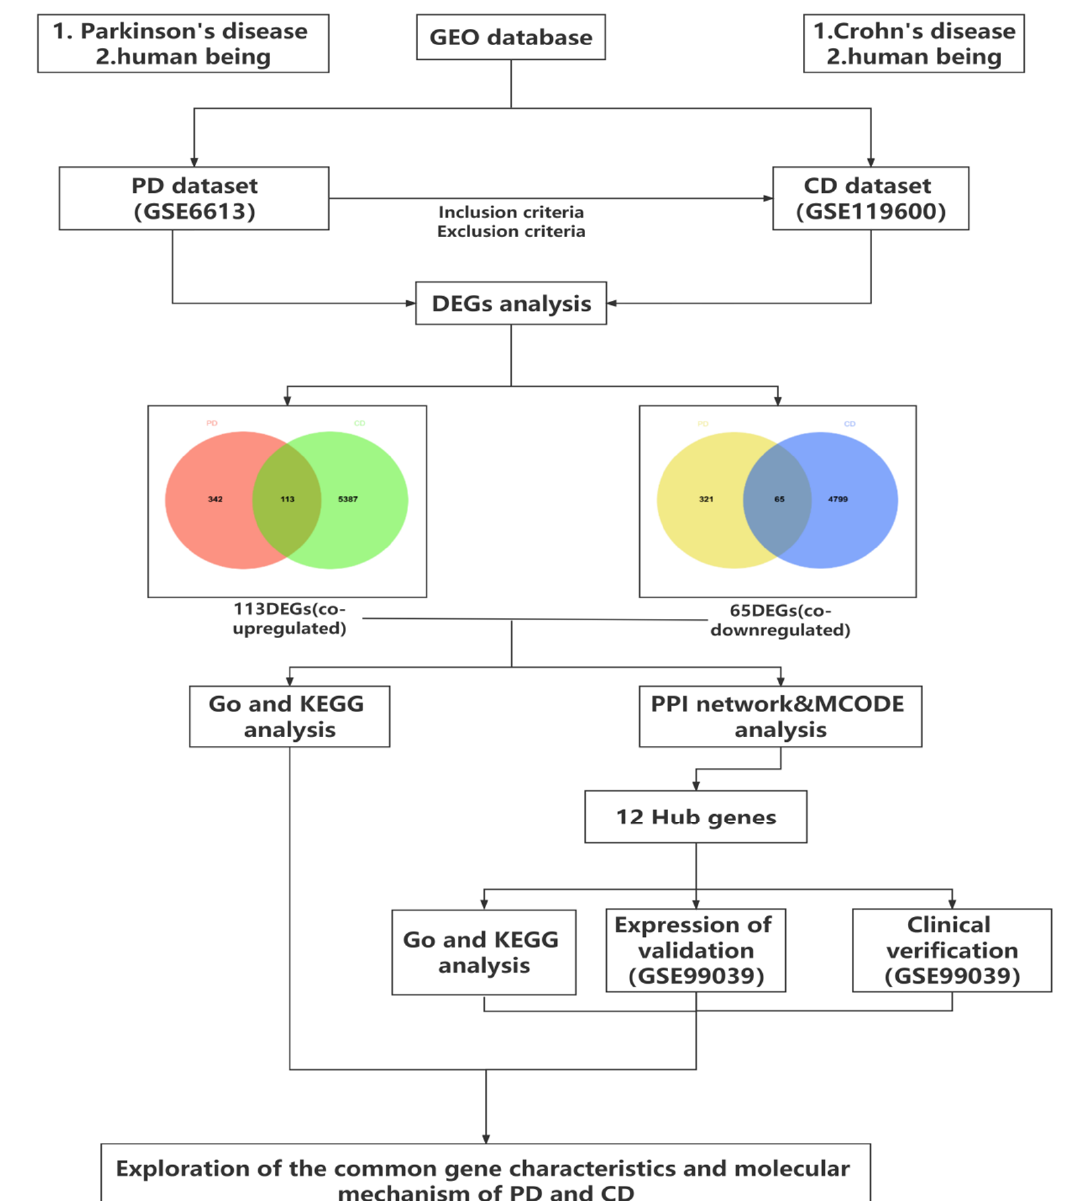
Figure 1. Research design flow chart.